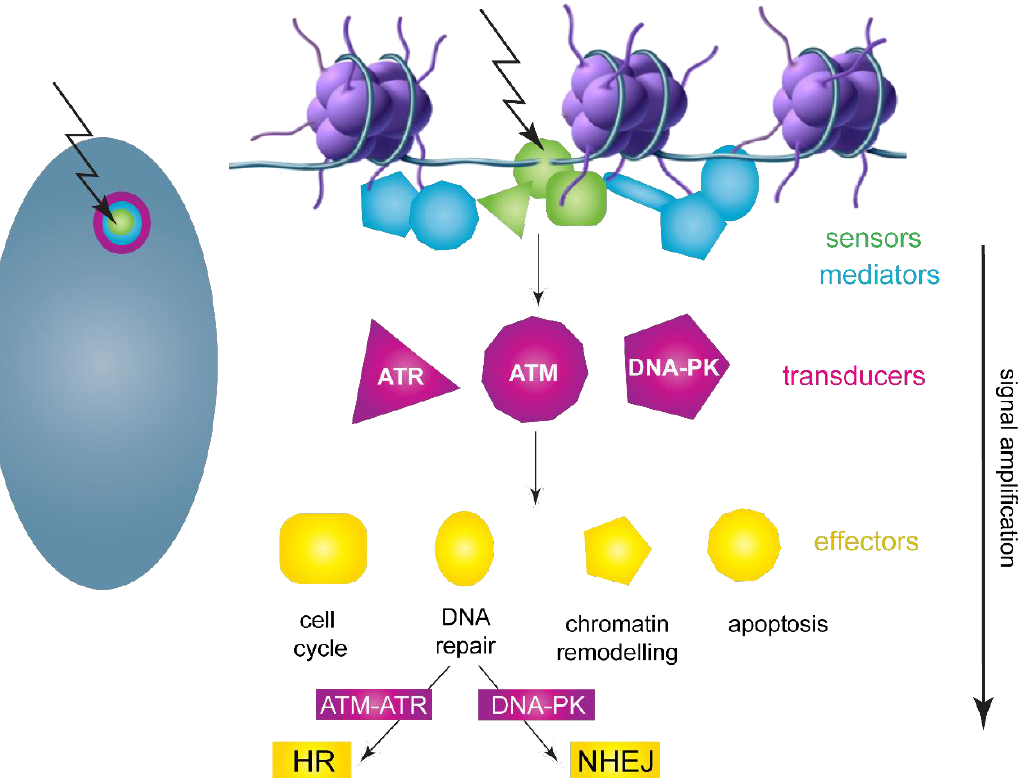
Figure 4. Diagram of the DNA Damage and Repair Response Pathway. DNA breaks or collapsed replication forks are detected by sensors that mark the site of damage. Three kinase signaling cascades (ATM, ATR, and DNA-PK) regulate and transduce the response to damage. With the help of mediator proteins, transducer and effector proteins transmit and greatly amplify the signal throughout the cell, resulting in a huge influx of factors to repair damage and remodel chromatin. Two major repair pathways, HR and NHEJ, are regulated by the ATM/ATR and DNA-PK pathways, respectively. The nucleus on the left contains an HPV replication focus that mimics a DDR focus. Adapted from [71].